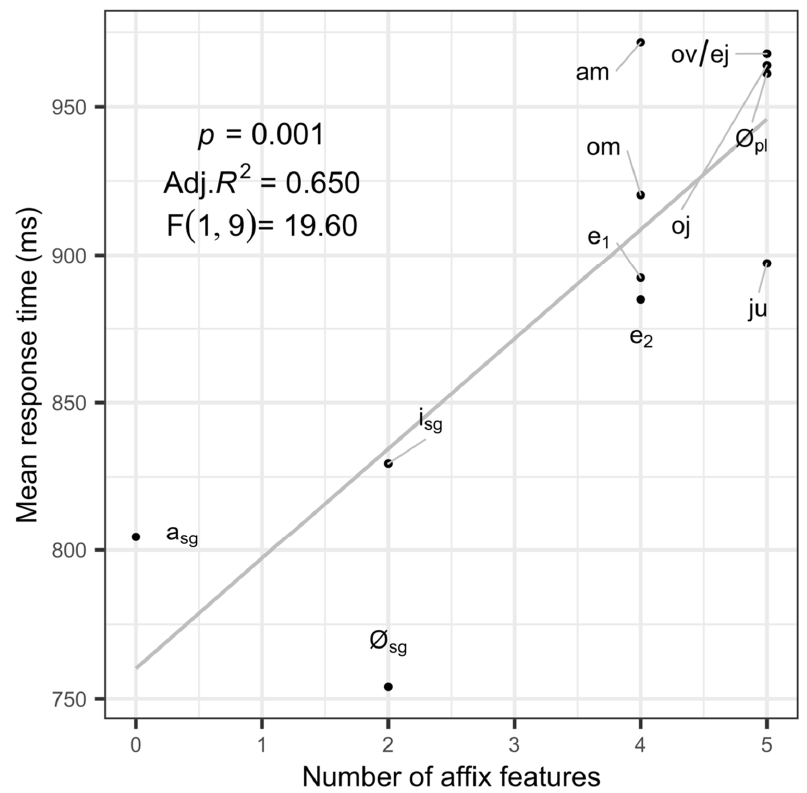
Figure 2. Effect of features on mean response time by affix.